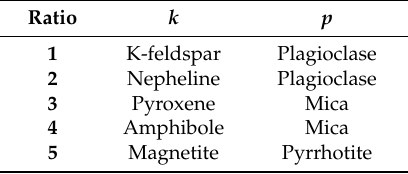
Table 2. Minerals used for ratio restrictions in Equation (8) in the LS-XRD